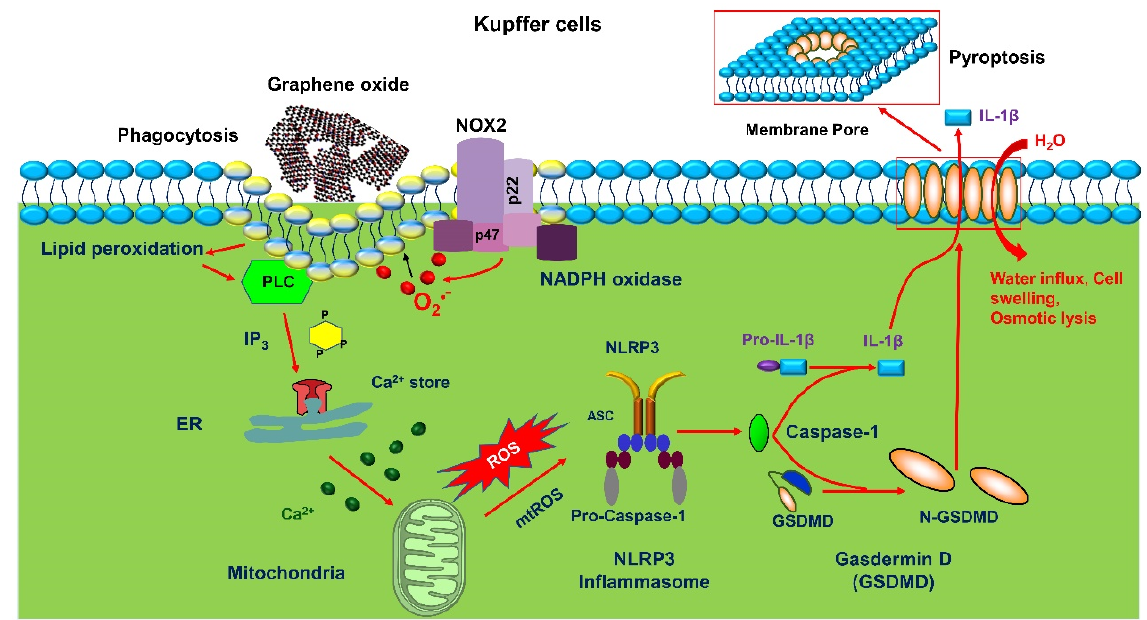
Figure 3. The cellular mechanism of GO-induced inflammatory effects. GOs were taken up into Kupffer cells through phagocytosis. Phagocytosis triggered NADPH oxidase mediated plasma membrane lipid peroxidation, leading to PLC activation, calcium accumulation, mtROS generation, caspase 1 activation as well as IL-1 β release and subsequent GSDMD-mediated pyroptosis.